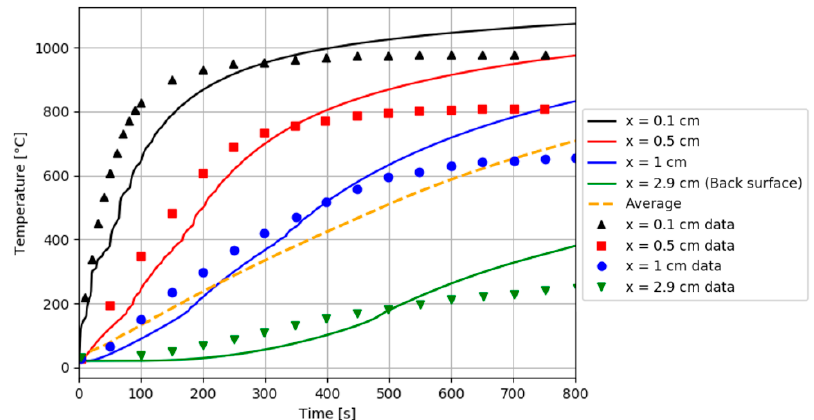
Figure 7. Prediction of temperature profiles. Comparison between the numerical simulation prediction (continuous lines) as a function of time and the experimental data of Henderson et al. [15] (discontinuous points) for a glass-filled/phenolic composite laminate exposed to a heat flux of 279.7 kW/m 2.